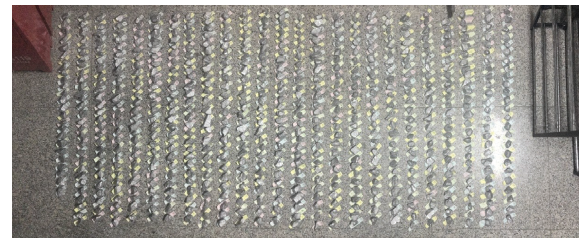
Figure 1: Sorting of rock material numbers.